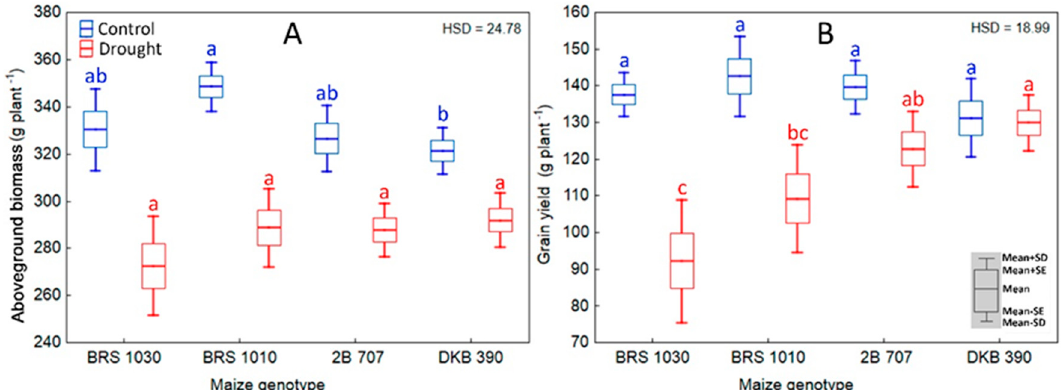
Figure 6. Aboveground biomass and grain yield for control and drought stressed maize plants. ( A ) Aboveground biomass and ( B ) grain yield in plants of maize genotypes grown in soil at field capacity (control) or subjected to water shortage (drought) at pre-flowering stage. A and B showed significant interaction between treatment and genotype ( p < 0.01) which indicates that the means of the genotypes should be compared by treatment. Boxes from different genotypes under the same treatment, topped by the same letter, are not statistically different according to Tukey’s test ( p < 0.05). At the 12th day of stress, soil and leaf water content, daily water consumption, and gas exchange measurements (represented by E), except intercellular CO 2 concentration, showed a high positive relationship to each other, but a high negative relationship to plant canopy temperature (Figure 7).